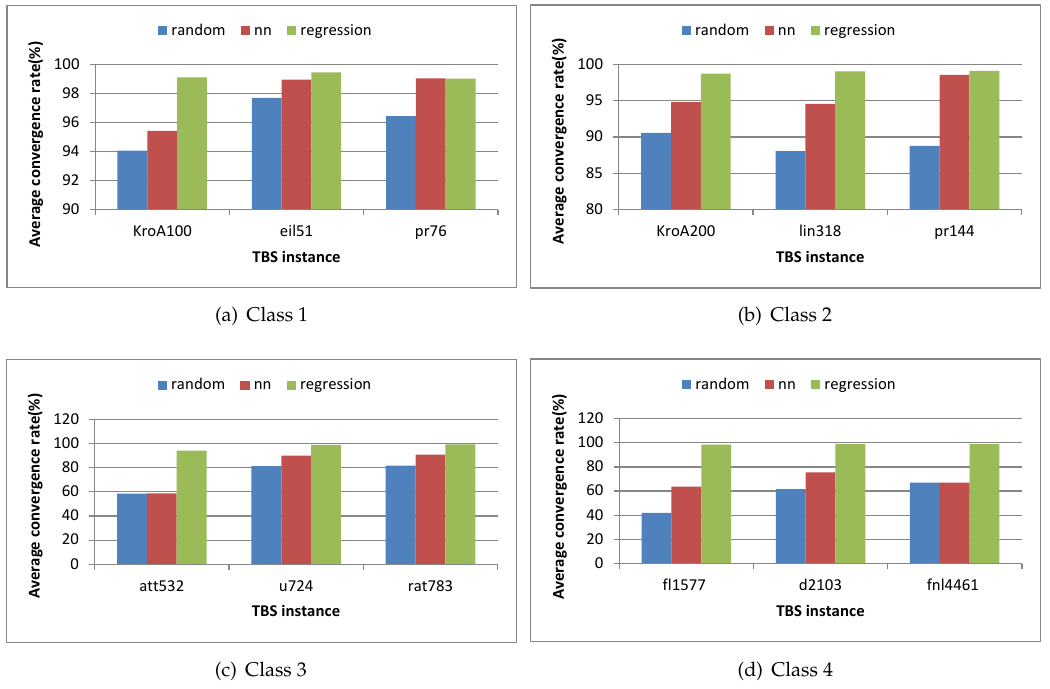
Figure 13. Performance of initialization techniques with respect to Error Rate (%). ( a ) Class 1; ( b ) Class 2; ( c ) Class 3; ( d ) Class 4.